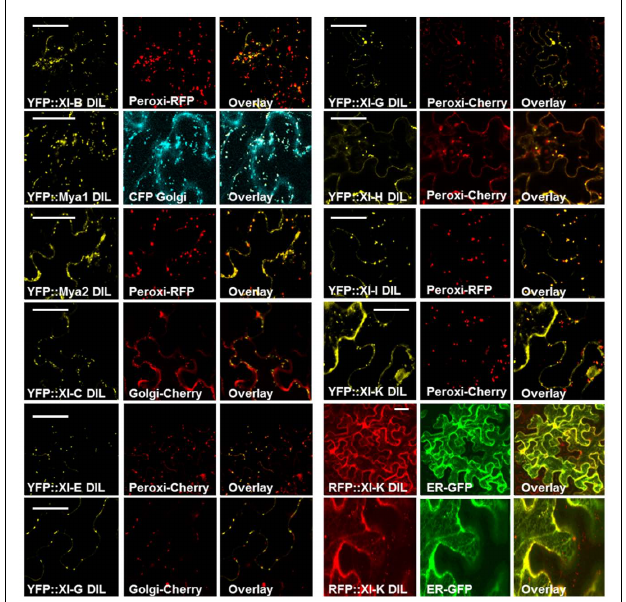
FIGURE 4 | Co-expression of the RFP::XI-K DIL and variousYFP::Myosin XI DIL domains with CFP, mCherry, GFP, and RFP markers for endoplasmic reticulum, peroxisomes, mitochondria, and Golgi in epidermal leaf cells of N. benthamiana . Scale bar = 50 μ m. Co-expression of YFP::Mya1 DIL with a plasmid construct appro-